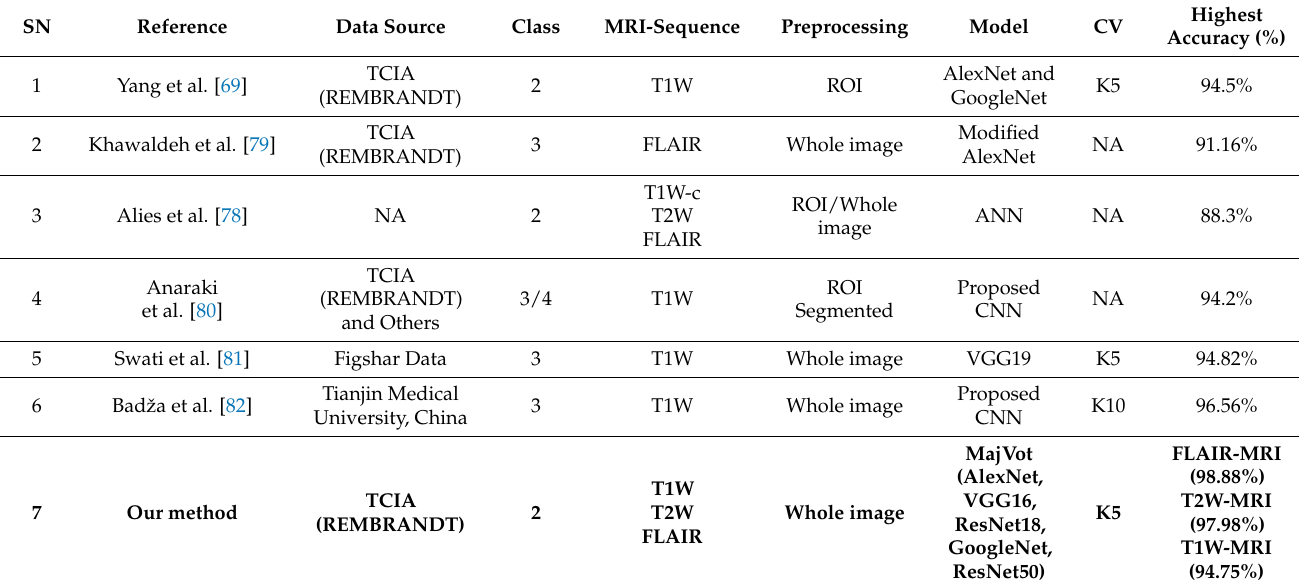
Table 14. The comparison of the proposed method with existing